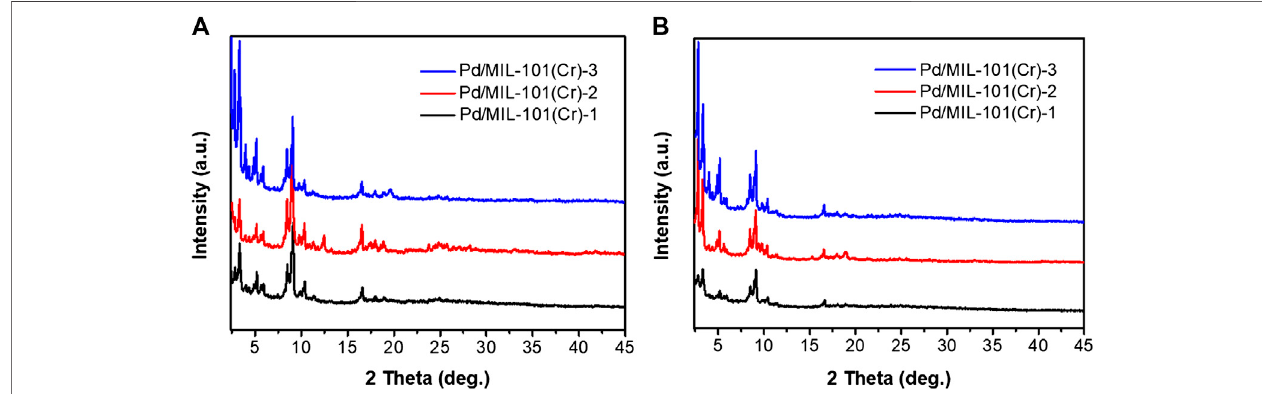
FIGURE 3 | XRD patterns of Pd/MIL-101(Cr) catalysts (A) before and (B) after 12 h of reaction.